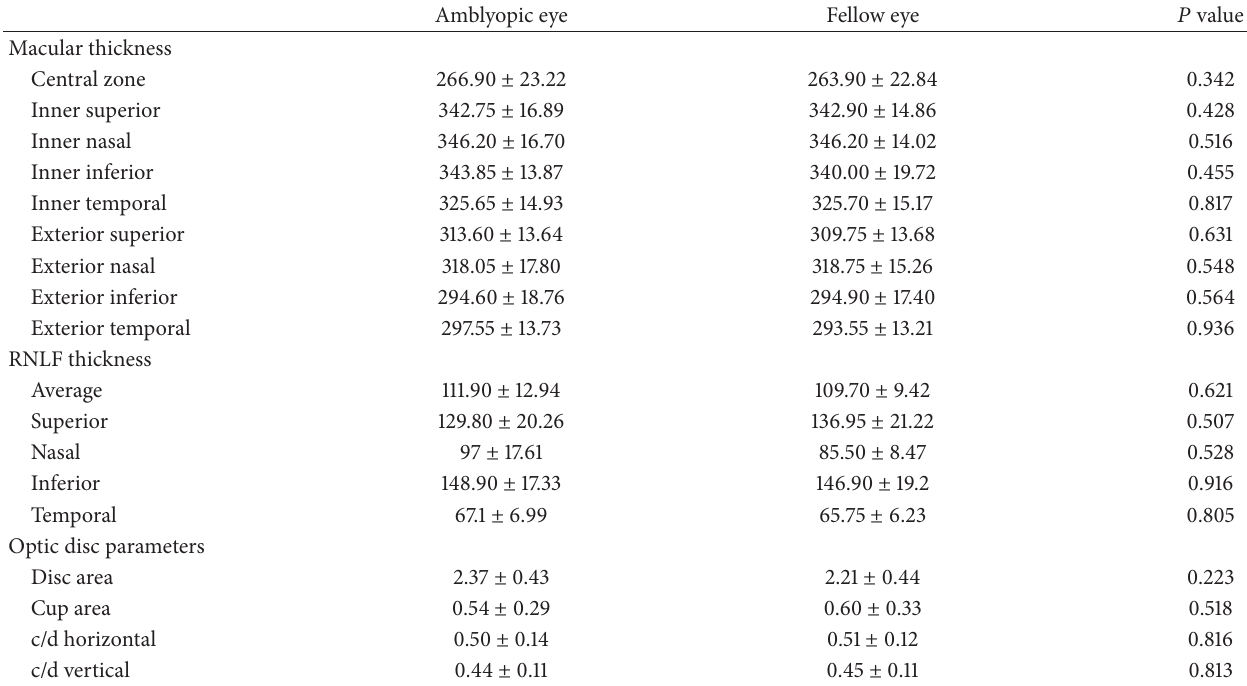
Table 1: Comparison of macular thickness, RNFL, and optic disc parameters.